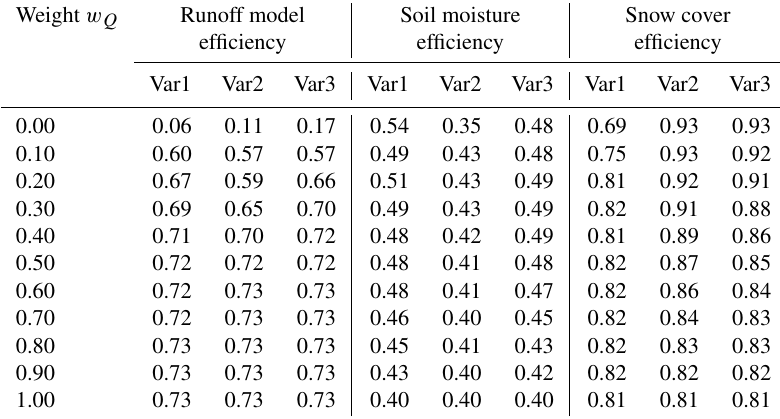
Table 5. Median of runoff (Eq. 2), soil moisture (Eq. 5), and snow cover (Eq. 6) model efficiency obtained from the following three multiple objective calibration variants: (1) satellite soil moisture (ASCAT) and runoff (var1), (2) satellite snow cover (MODIS) and runoff (var2), and (3) satellite soil moisture (ASCAT), satellite snow cover (MODIS), and runoff (var3) in 213 catchments in the validation period